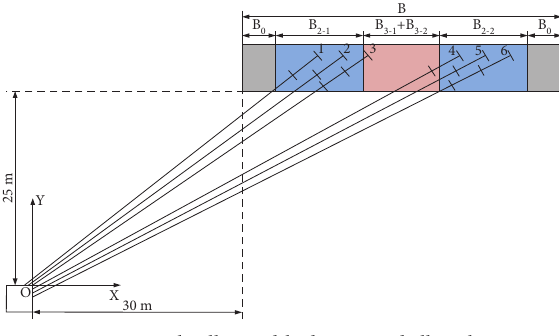
Figure 12: Coal pillar width direction drilling layout. Table 2: Coal pillar width direction drilling layout parameters.